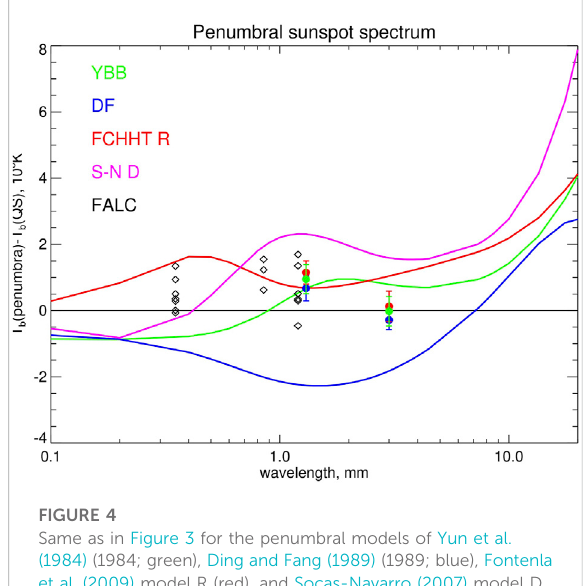
FIGURE 3 Difference between the umbral brightness (in temperature units) and the QS brightness, plotted as a function of wavelength for the umbral models, including the models of Avrett (1981), of Maltbyetal.(1986),ofSeverinoetal.(1994),ofSocas-Navarro (2007), of Fontenla et al. (2009), of Avrett et al. (2015), and of de la Cruz Rodríguez et al. (2016), marked as DLCR 2016. The individual models are identi fi ed by color as indicated in the fi gure. The solid black line is the reference QS atmosphere FALC. The colored fi lled circles and error bars indicate the umbral ALMA mean brightness values together with the rms values for the inner umbra (blue), outer umbra (red), and the whole umbra (green) at 1.3 and 3 mm. The fi gure also depicts the BIMA measurements obtained at 3.5 mm by Loukitcheva et al. (2014) at a resolution of 12 ″ (triangles), the measurements at 0.35, 0.85, and 1.2 mm (diamonds) made by Lindsey and Kopp (1995) at a resolution of 14 ″ – 17 ″ ; and brightness observations at 2.6 and 3.5 mm obtained from the Nobeyama 45 m telescope by Iwai and Shimojo (2015) at a resolution of 15 ″ , and at 8.8 mm from the NoRH by Iwai et al. (2016) at a resolution of 5 ″ – 10 ″ (plus signs). From Loukitcheva et al. (2017). Reproduced by permission of the AAS.